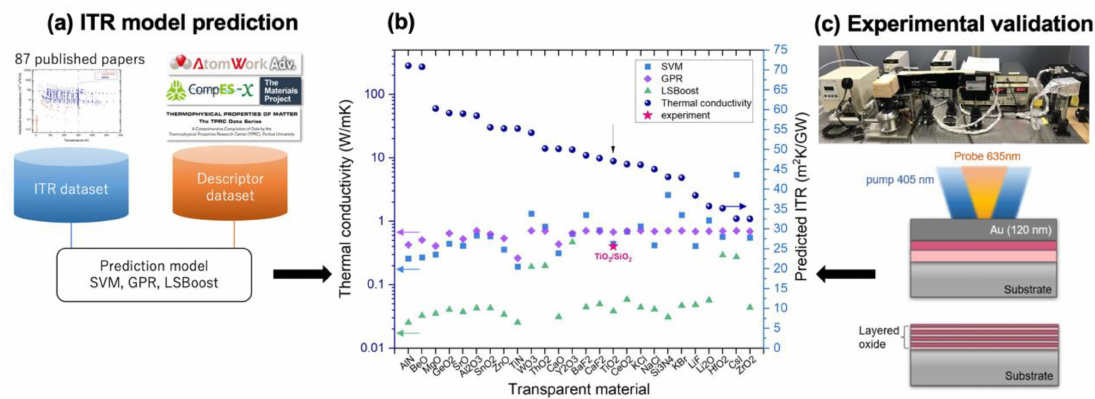
Figure 1. Schematics of the data-driven material selection to combine the machine-learning method and experimental validation. ( a ) ITR prediction model. Detailed information of the datasets is presented in our previous work [26]. ( b ) Thermal conductivity of various transparent materials and their predicted ITR with SiO 2 . ( c ) Schematic of the experimental validation set up. The images show the FDTR of ITR measurement. The probe laser of 635 nm and pump laser of 405 nm were applied for detecting and heating the sample. The bilayer thin film with Au-top layer deposited on the substrate was used for evaluating the ITR value after the prediction with the model. TiO 2 /SiO 2 with a high ITR of 26.56 m 2 K/GW (pink star in ( b )), which was close to the predicted values, was